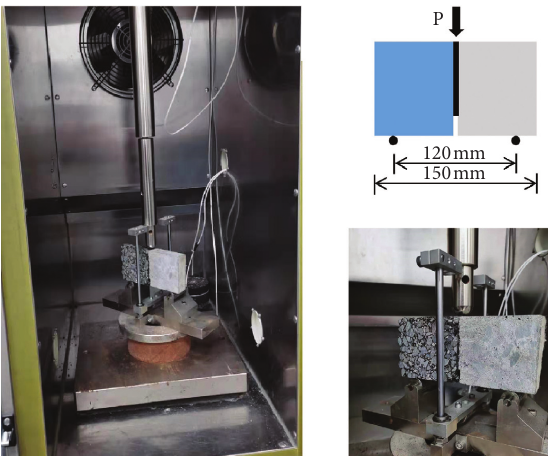
Figure 4: Test setup. Table 4: Testing